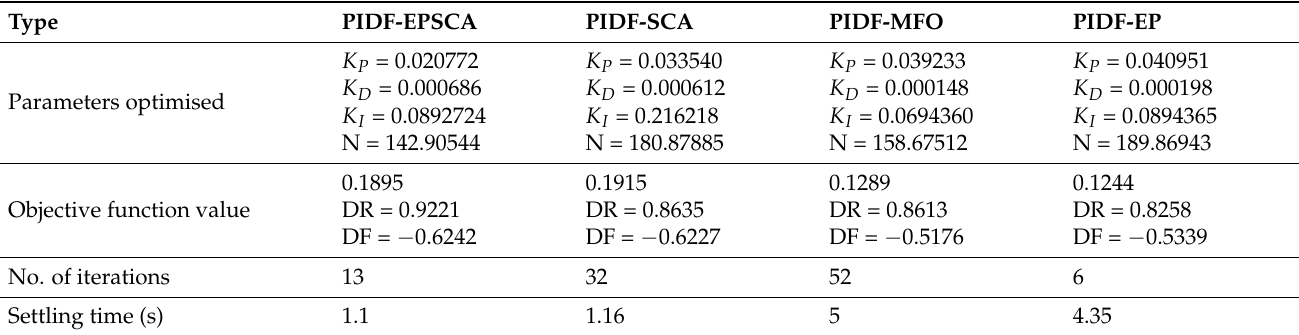
Table 4. Comparison of PIDF-EPSCA, PIDF-SCA, PIDF-MFO, and PIDF-EP for Scenario